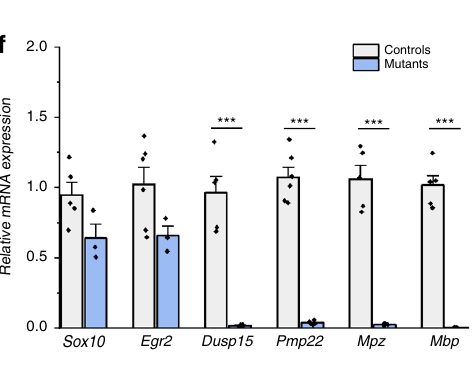
RNA-seq analysis in sciatic nerves of controls and mutants . To further de fi ne origin of Adar1 mutant SCs arrest and assess global changes in gene regulation, we performed transcriptomic analysis (RNA-seq) of sciatic nerves isolated from three control and three HtPA-Cre; Adar1 fl / fl ;R26R mutant animals at P4. The steady-state level of 3009 mRNAs differed by at least twofold between the